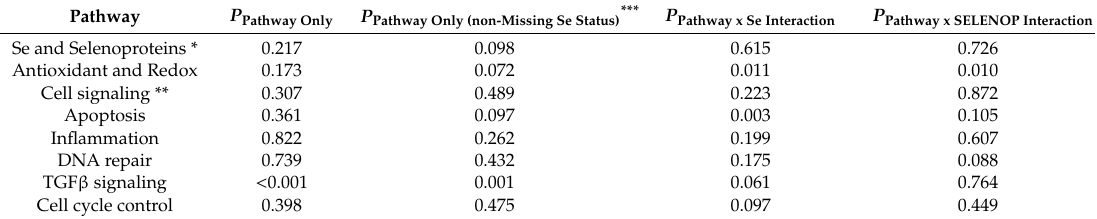
Table 4. P -values for genetic pathways and pathway-selenium (Se) status interactions and colorectal cancer risk, the EPIC study,